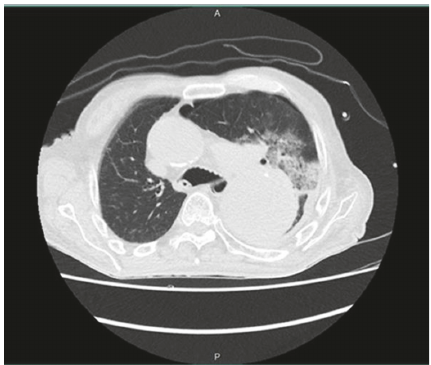
Figure 1: Mediastinal widening and left upper lobe opacity.